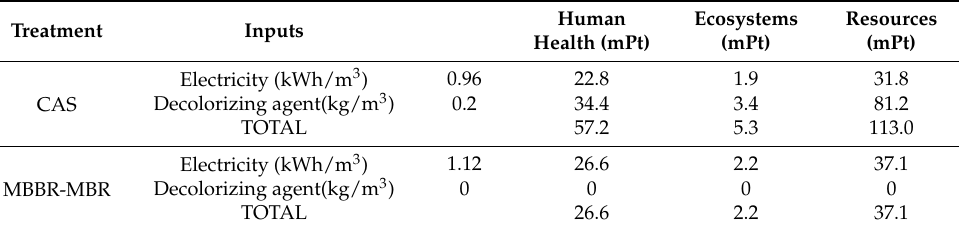
Table 10. Comparison of environmental impacts of CAS vs. MBBR-MBR: endpoint analysis.